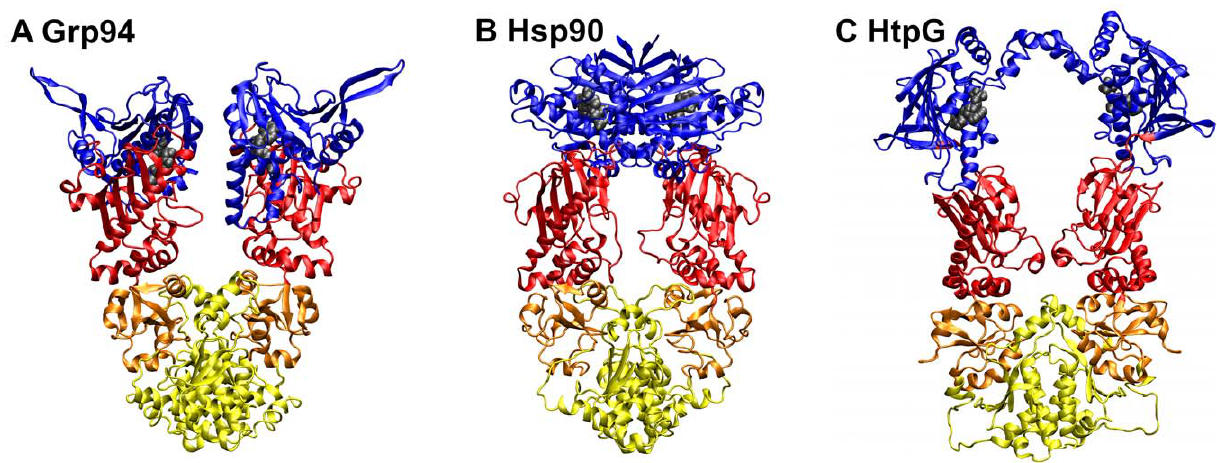
Figure 1. Starting structures used for the MD simulations. A , canine ATP-bound Grp94 structure, PDB entry 2O1U, with ATP lid and missing loops modeled as described in Materials and Methods. B , yeast ATP-bound Hsp90 structure, PDB entry 2CG9, with charged linker and disordered loops modeled as described in [35]. C HtpG structure, PDB entry 2IOP.pdb, corresponding to the ADP-bound form resolved in [17]. The structural domains are colored as follows: blue, N-terminal domains; Red, M-large domains; Orange, M-small domains; Yellow, C-terminal domains. The domains span the following sequence intervals: Grp94 (NTD: 85–285; M-large: 330–511; M-small: 512–602; CTD: 603–749); Hsp90 (NTD: 2–215; M-large: 264– 426; M-small: 427–526; CTD: 527–676); HtpG (NTD: 1–215; M-large: 216–400; M-small: 401–490; CTD: